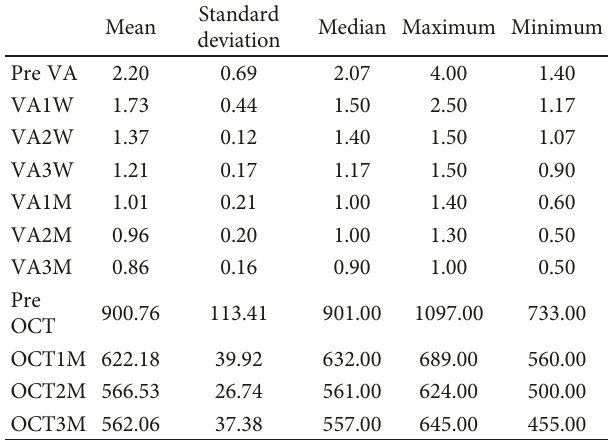
Table 1: The mean, standard deviation, median, maximum, and minimum for the visual acuity and central corneal thickness (pre VA: preoperative VA; W: week; M: month; OCT: central corneal thickness measured by OCT; pre OCT: preoperative